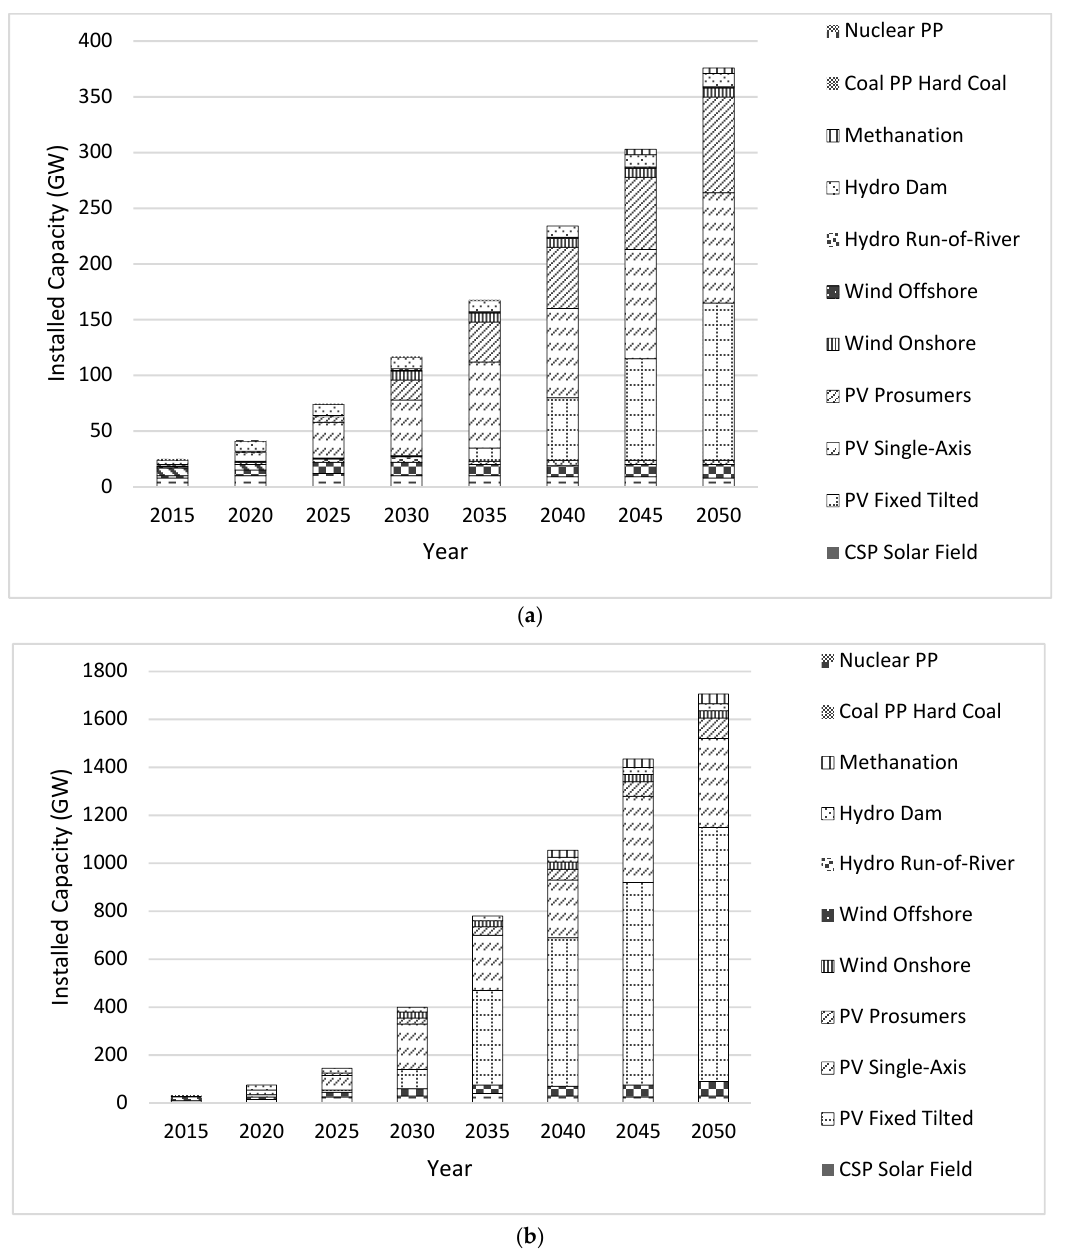
Figure 16. Collective installed capacity from all of the renewable resources by 2050 for ( a ) the power and ( b ) integrated scenarios.